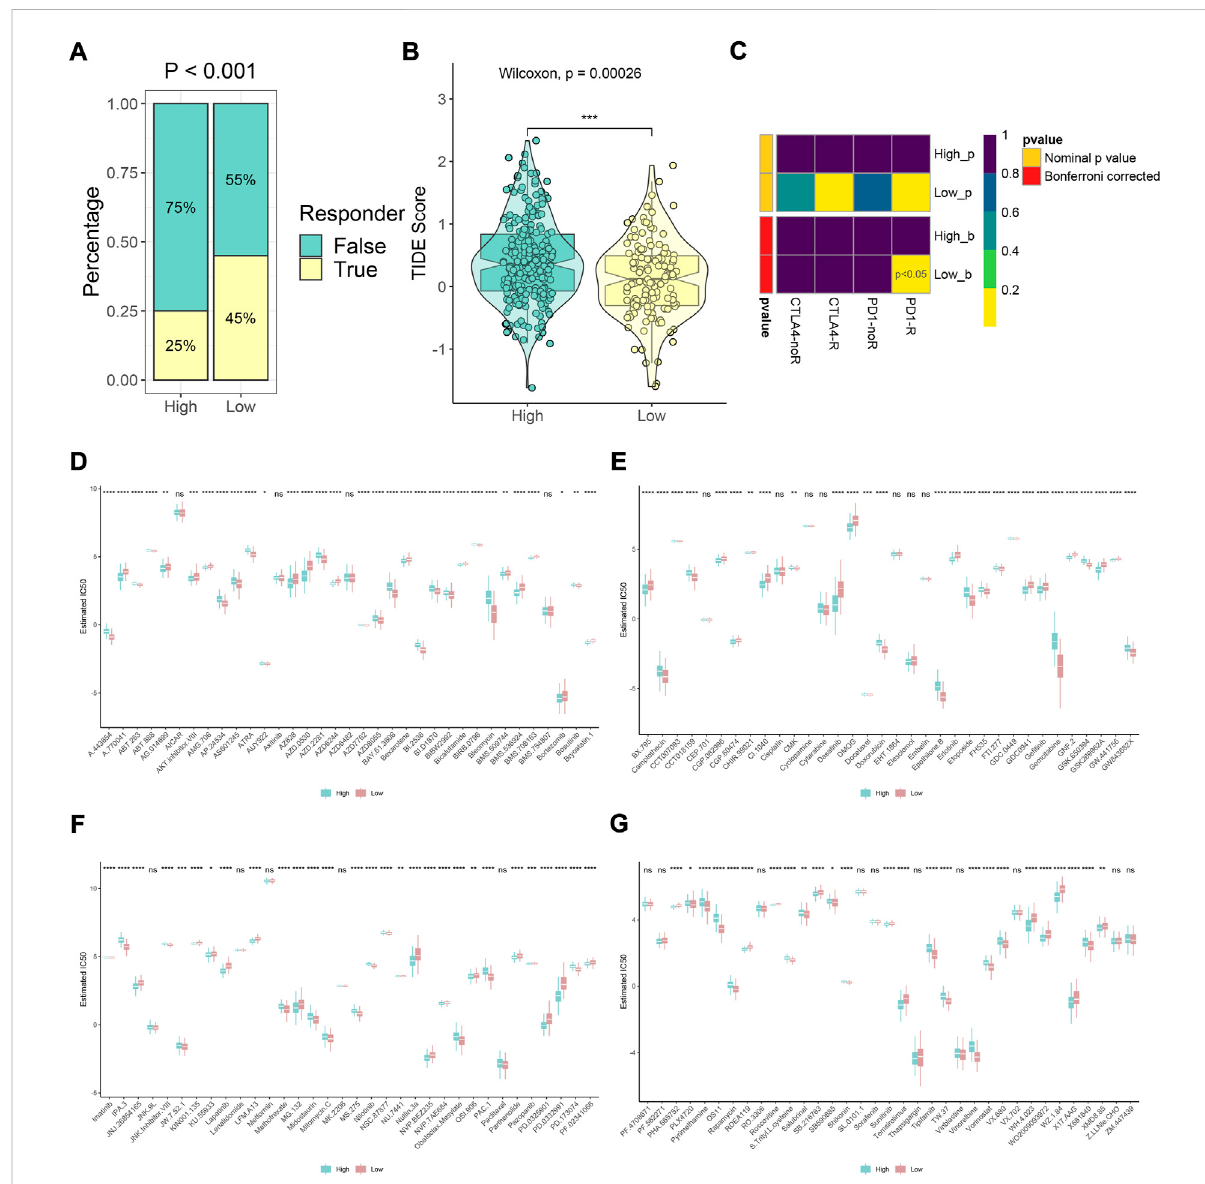
FIGURE 8 Immunotherapyresponsepredictionandpotentialdrugexploration. (A,B)